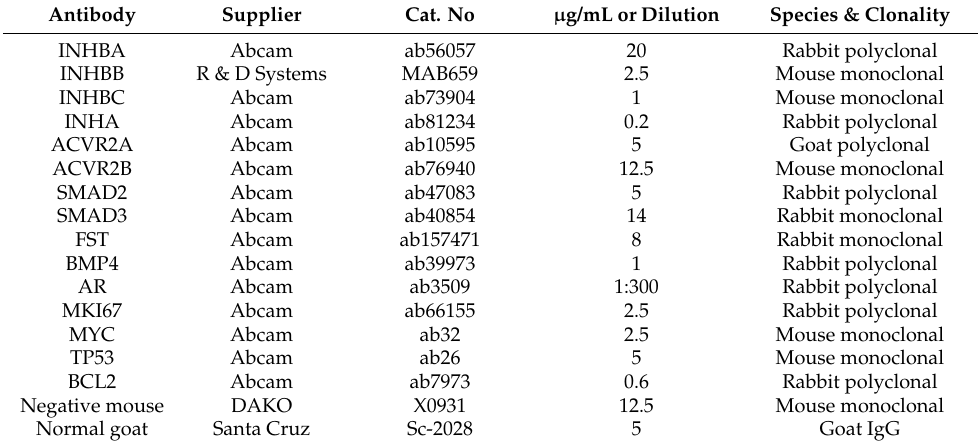
Table 1. Antibodies used for